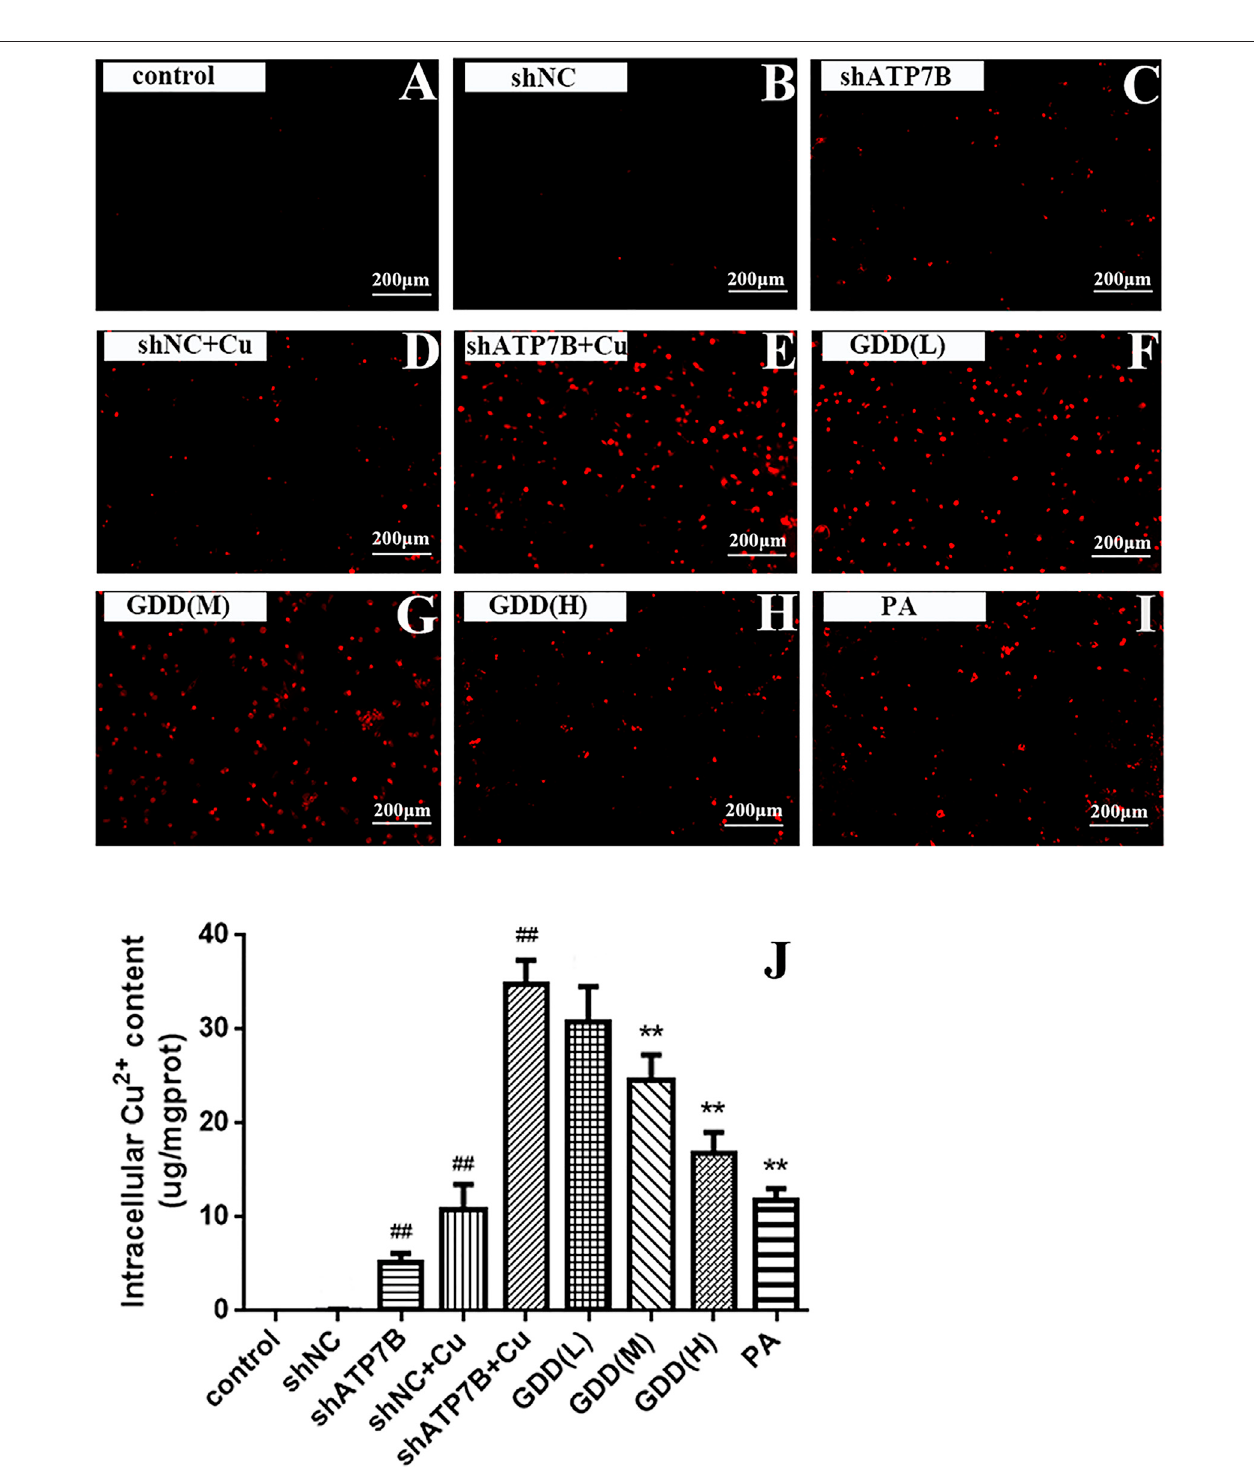
FIGURE2|(A – I) Cu 2+ fl uorescenceintensityofcopper-laden HLD hepatocytes treatedwithGDD by fl uorescence microscope(magni fi cation =×100); (J) effectof GDD on content of Cu 2+ in copper-laden HLD hepatocytes ( (cid:1) x ± s , n (cid:1) 6). # p < 0.05, ## p < 0.01 compared with control group; * p < 0.05, ** p < 0.01 compared with shATP7B + Cu